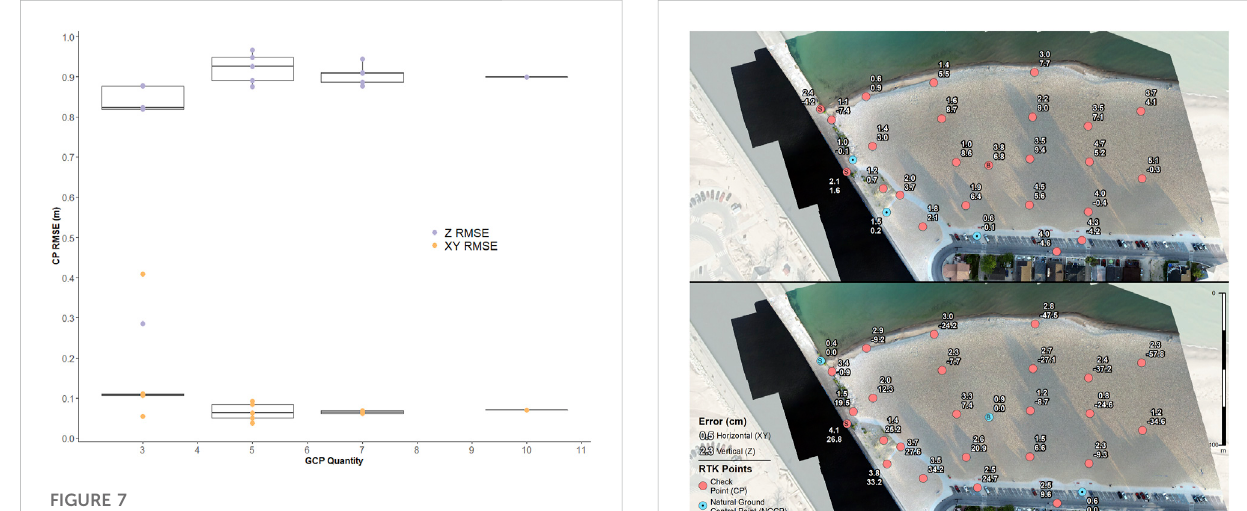
FIGURE 7 Bluff-1 NGCP quantity vs. RMSE. Purple points represent vertical (Z) RMSE, and orange points represent horizontal (XY) RMSE. Each pointrepresentstheRMSEofasinglereplicationforagivenquantityof NGCPs. Boxes represent the interquartile range (IQR), whiskers represent points < 1.5*(IQR) above or below the IQR, and dots represent points > 1.5*(IQR) above or below the IQR.